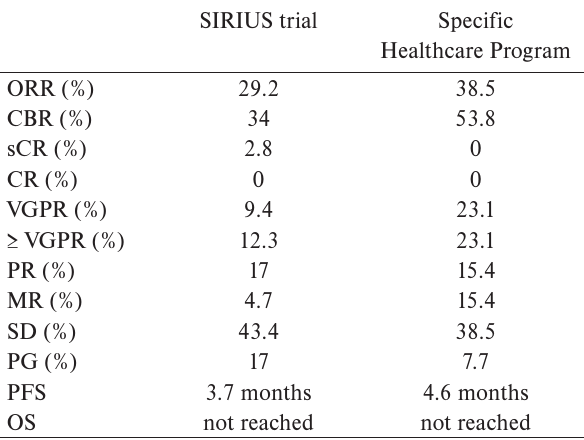
Table 2. Response rates and intervals in daratumumab mono- therapy and indirect comparison with SIRIUS trial 3